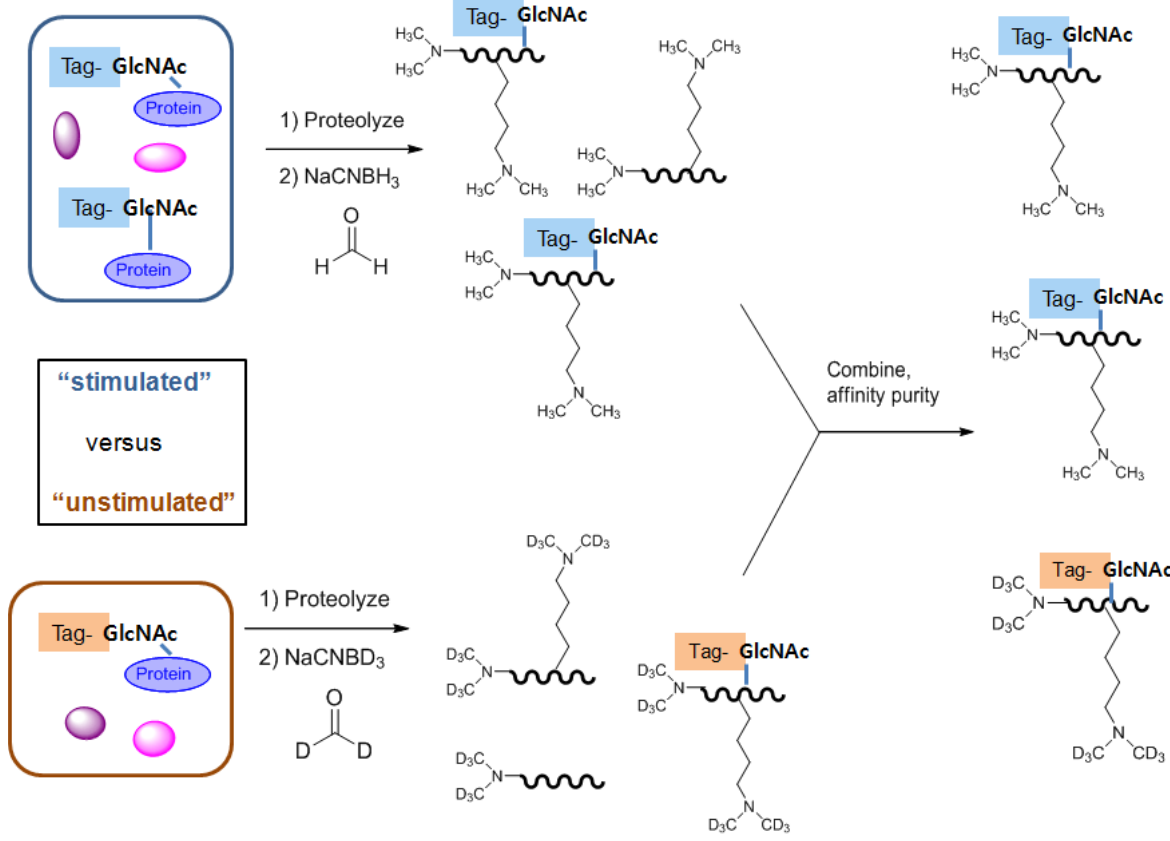
Figure 6. Quantitative isotopic and chemoenzymatic tagging (QUIC-tag)